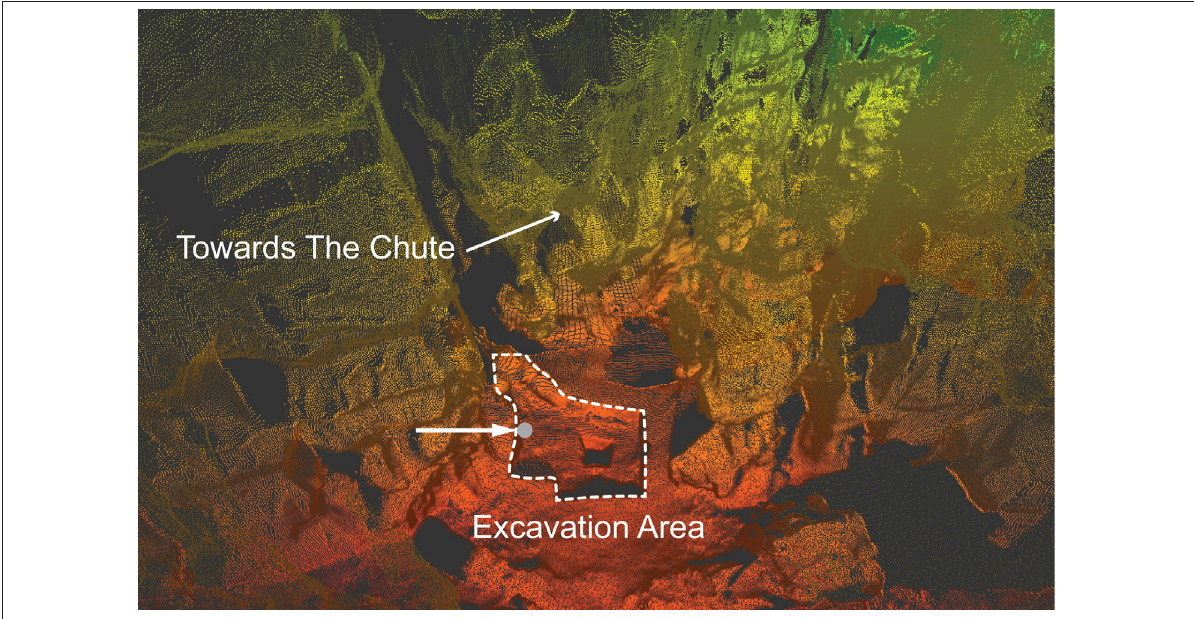
Figure 8: Point cloud data generated from scans conducted with the Faro Focus 3D laser scanner indicating the same reference pin marker as shown in Figures 6 and 7 within the excavation area of the Dinaledi Chamber of the Rising Star Cave.